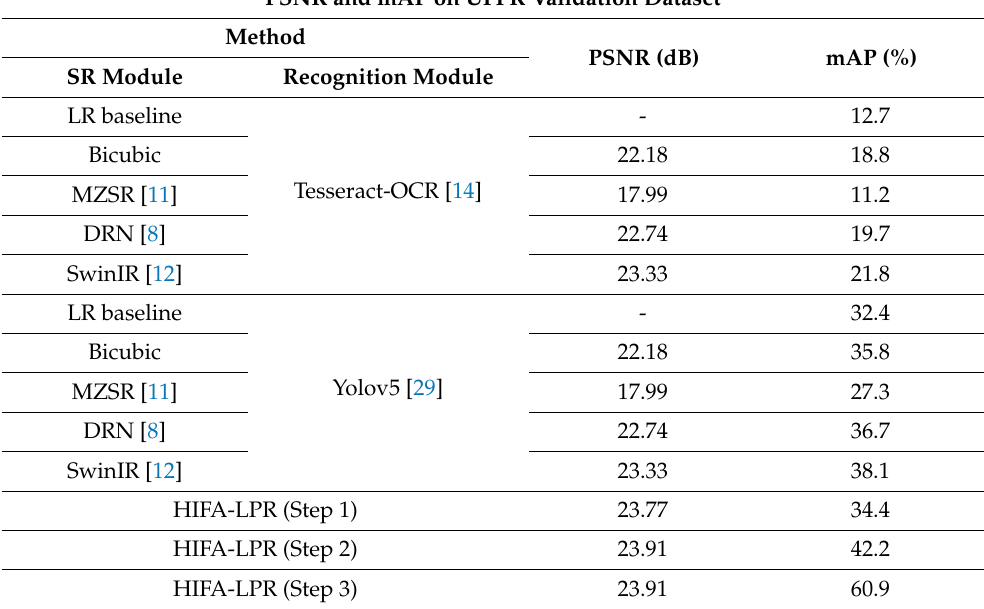
Table 2. Comparison between the HIFA-LPR model and other existing approaches for scale factor ( × 4) on the UFPR